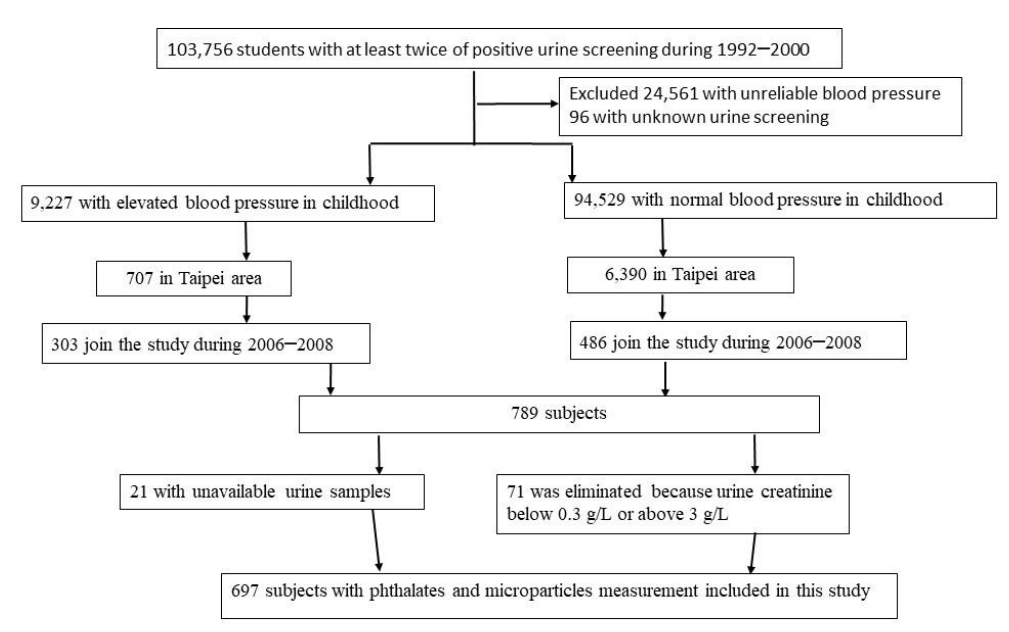
Figure 1. Flow chart of the study population recruitment.